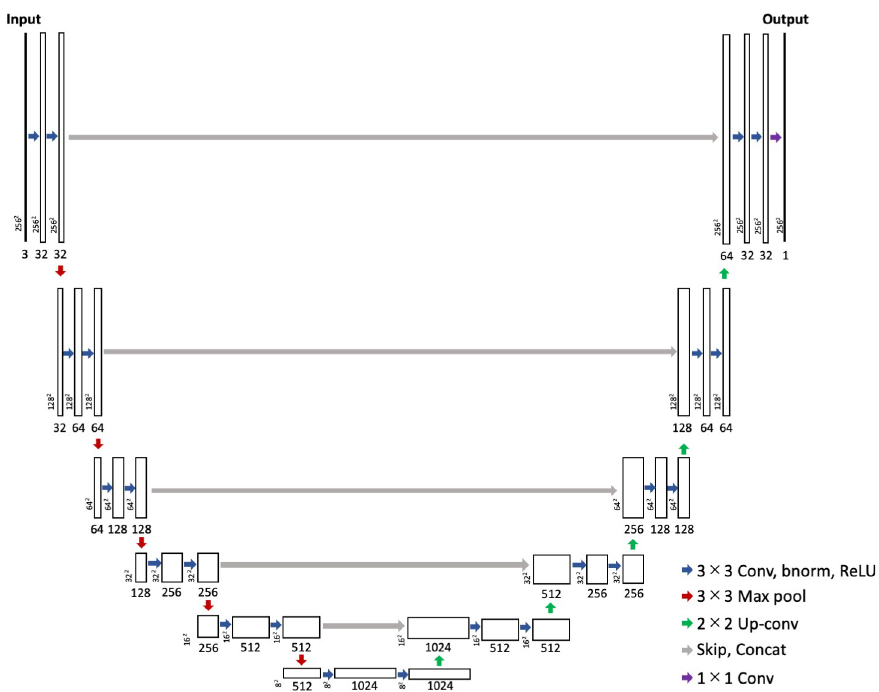
Fig 3. The network architecture used for the extraction of the feeding trails. The left part of the figure shows down- sampling operation and right part shows up-sampling process. Each box corresponds to a multi-channel feature map. The number of channels is denoted on the bottom of the box. The x-y-size is provided at the lower left edge of the box. The blue arrow shows convolution operations; the convolution with a 3 × 3 kernel size, followed by the batch normalization, leaky rectified linear units (ReLU) activation. The red arrow shows max-pooling layer operation with the window size of 2 × 2, and the green arrow shows 2 × 2 up-convolution. The gray arrow shows the skip connection in which the feature of the encoder layer is copied and then concatenated to the result of the deconvolution. The resulting feature layer is generated by the 1 × 1 convolution (purple arrow).